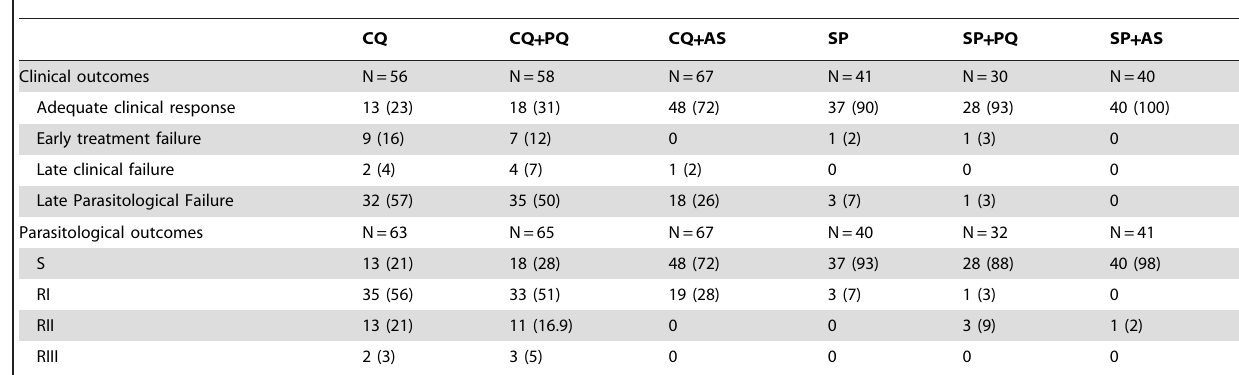
Table 4. Clinical and parasitological outcomes after 28 days follow-up: n (%).